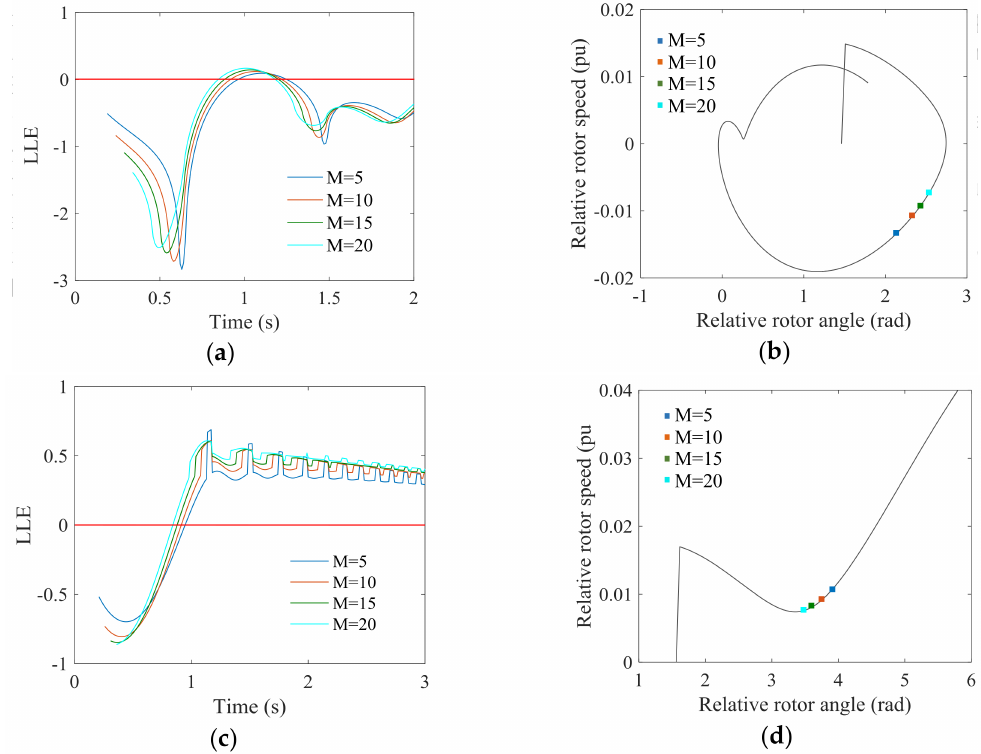
Figure 14. Simulation results of different initial conditions for Case 1 and Case 2. ( a ) LLE–time curves for case 1; ( b ) phase-plane trajectory after clearing the fault of Case 1; ( c ) LLE–time curves for Case 2; ( d ) phase-plane trajectory after clearing the fault of Case